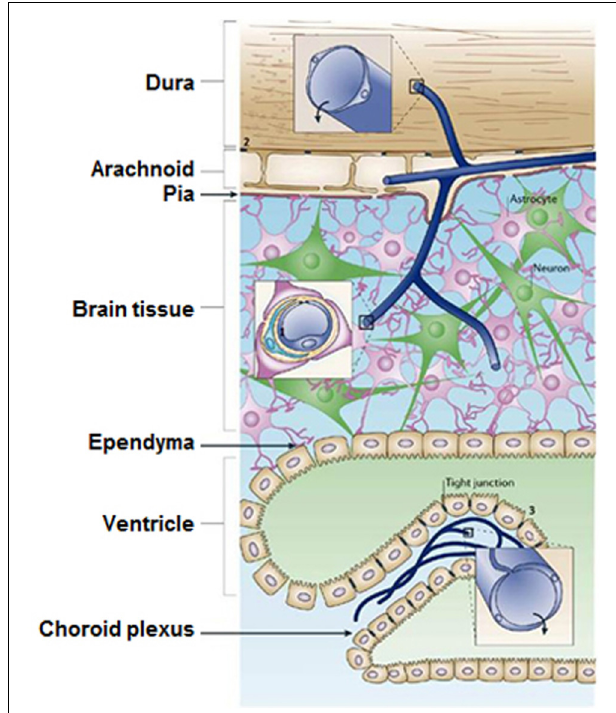
FIGURE 3 | The locations of tight junction barriers in the central nervous system. (1) brain endothelium forming the BBB, (2) the arachnoid epithelium forming the middle layer of the meninges, and (3) the choroid plexus epithelium which secretes cerebrospinal fluid. (Reprinted by permission from Macmillan Publishers Ltd: Abbott et al.,